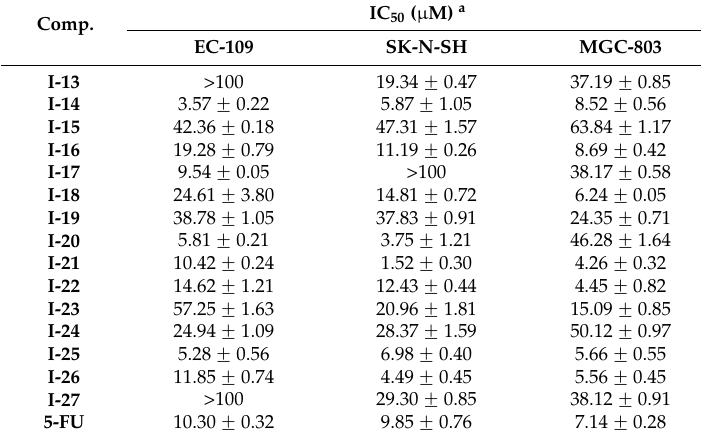
Table 1. Inhibitory results of preliminary evaluation against three cancer cell lines for the target compounds. Comp.